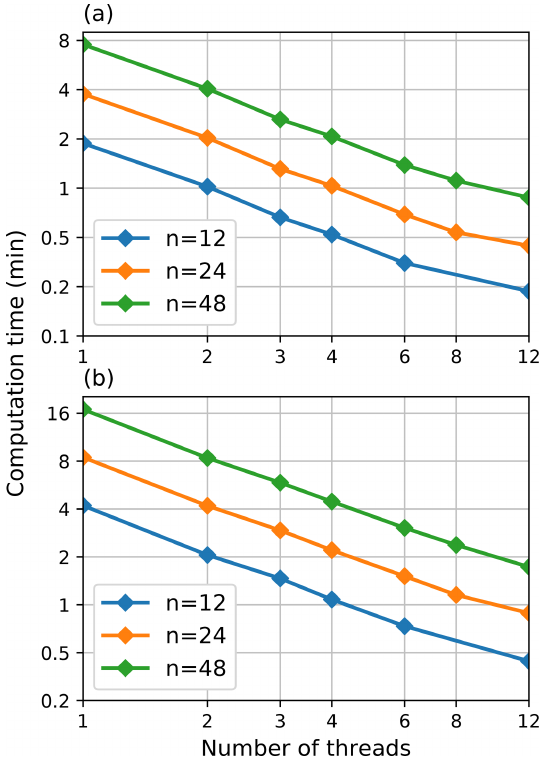
Figure 15. Averaged computation times of pysteps nowcast ensem- bles with different ensemble sizes and number of parallel threads for the (a) MeteoSwiss and (b) FMI domain. The grid sizes for the domains are 710 × 640 and 760 × 1226 pixels, respectively. The 1h nowcasts with 12 time steps of 5min were computed for both do- mains. The computation times include only the ensemble computa- tion, excluding the optical flow, the initialization of the model and writing the results to